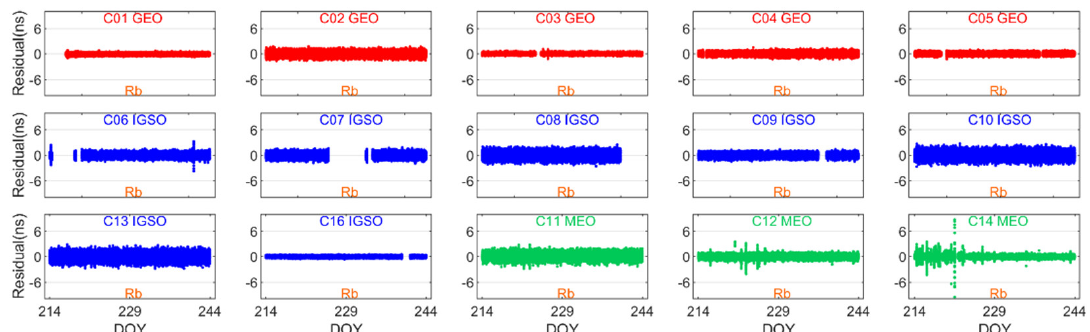
Figure 11. Fitting residual series of the BDS-2 satellites.